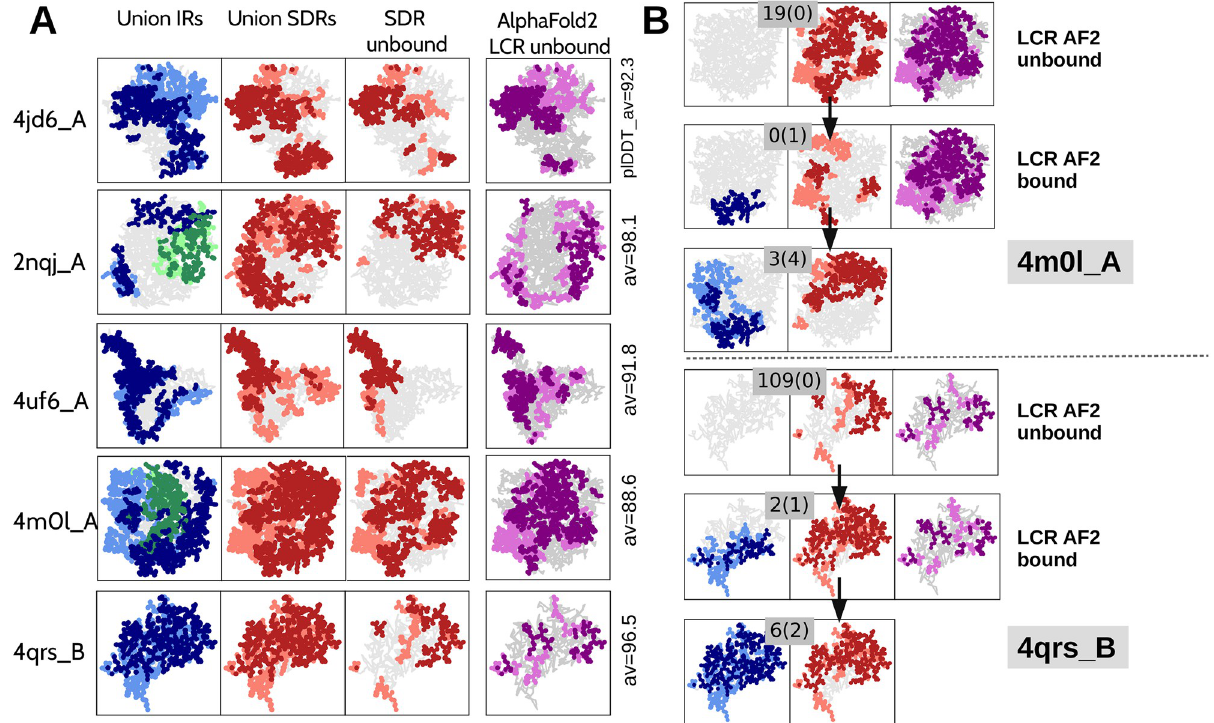
Fig 5. IR and SDR analysis of five protein clusters (4jd6_A, 2nqj_A, 4uf6_A, 4m0l_A and 4qrs_B) and comparison with AF2 uncertainty (i.e. low confident regions, LCR). A The union of all interface regions (IR, blue for proteins and green for DNA and RNA; first column) and the union of soft disorder regions (SDR, red; second column) identified by graph analysis are compared with the regions of the AF2 model that predict with high uncertainty the structure of the unbound protein (i.e. the pLDDT is below the protein average; purple; fourth column). For each chain, the average pLDDT value for all residues is shown on the right. The SDR value calculated for the unbound chain is also shown (third column). The structures and regions have been projected in two dimensions, and residues that are forward (with respect to the centre) are shown in a darker shade than those that are backward. B. Two hierarchies, for 4m0l_A and 4qrs_B, are described. The AF2 low confidence region (LCR) is calculated for the unbound and bound forms, resulting in the same levels of uncertainty, while the corresponding SDR changes from the unbound to the bound